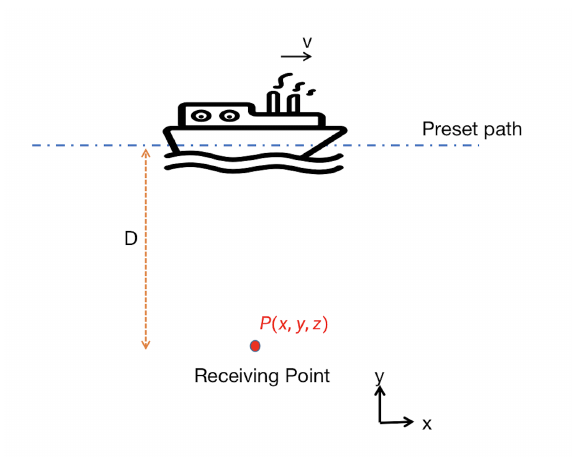
Figure 4. The schematic of the experimental survey line (top